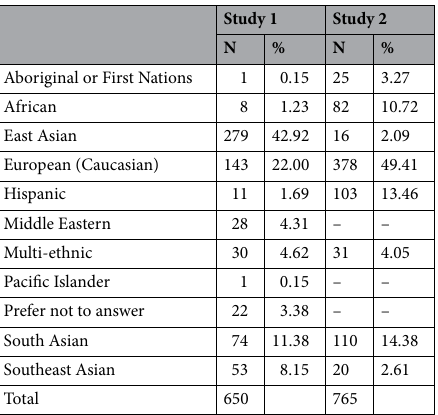
Table 4. Ethnicity breakdown for Study 1 and Study 2 participants. Total number (N) and percentage (%) of each ethnicity that participated in Study 1 and Study